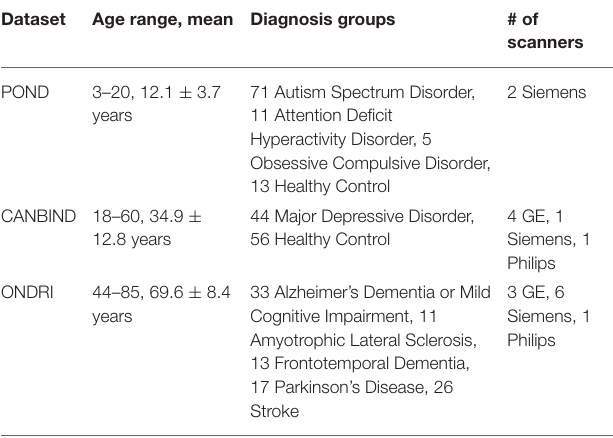
TABLE 3 | Participant demographics of scans used in testing defacer accuracy.